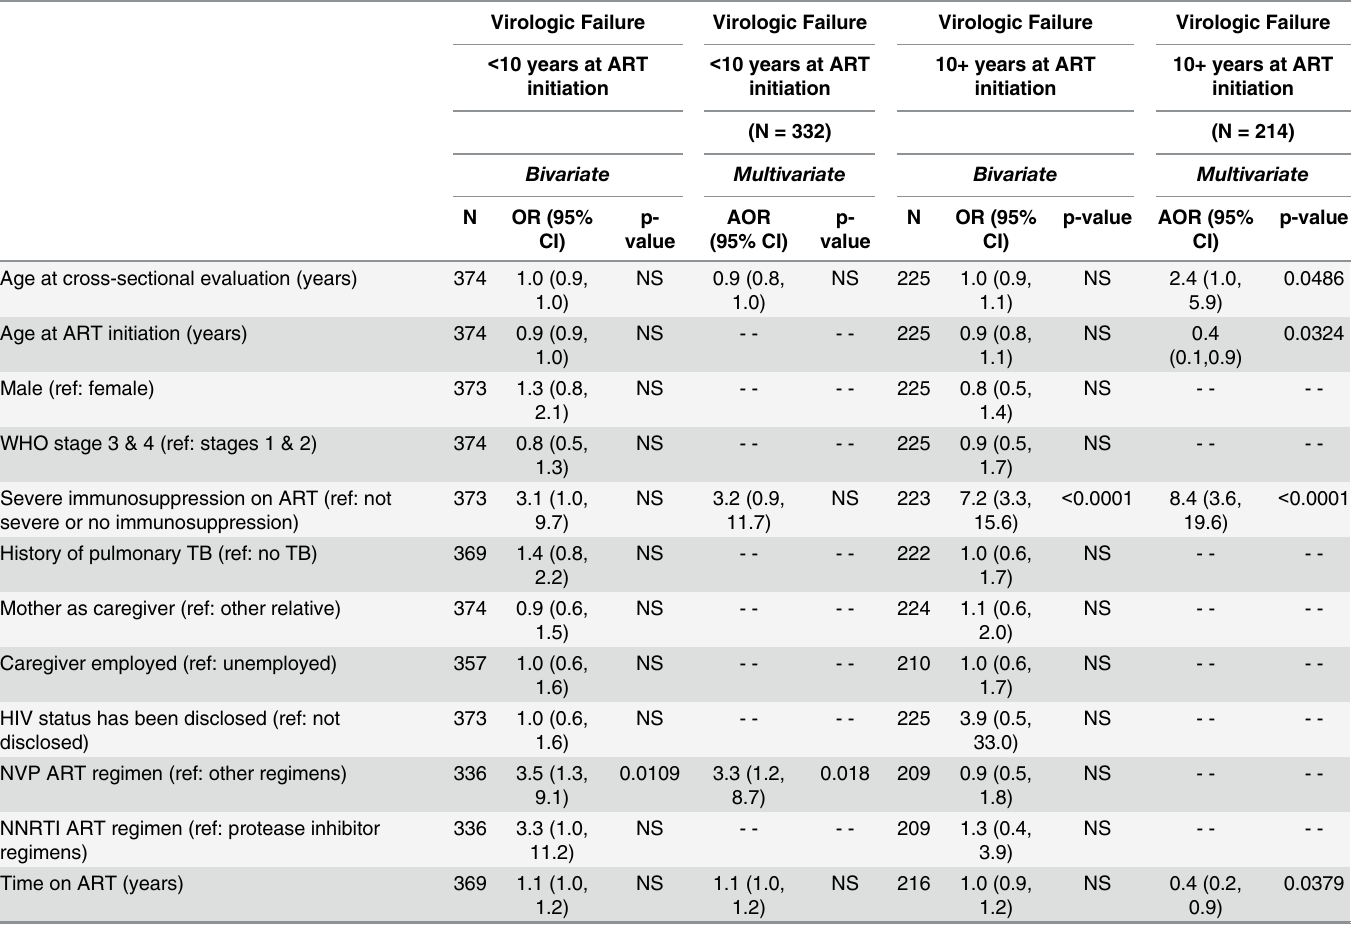
Table 3. Factors associated with virologic